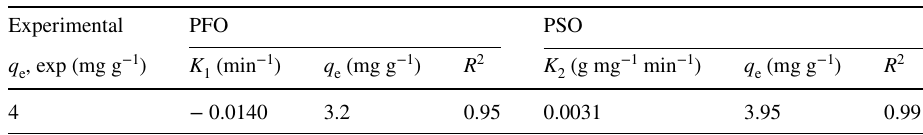
Table 2 Langmuir isotherm and Freundlich isotherm parameter values for MB adsorption onto mesoporous silicalite-1